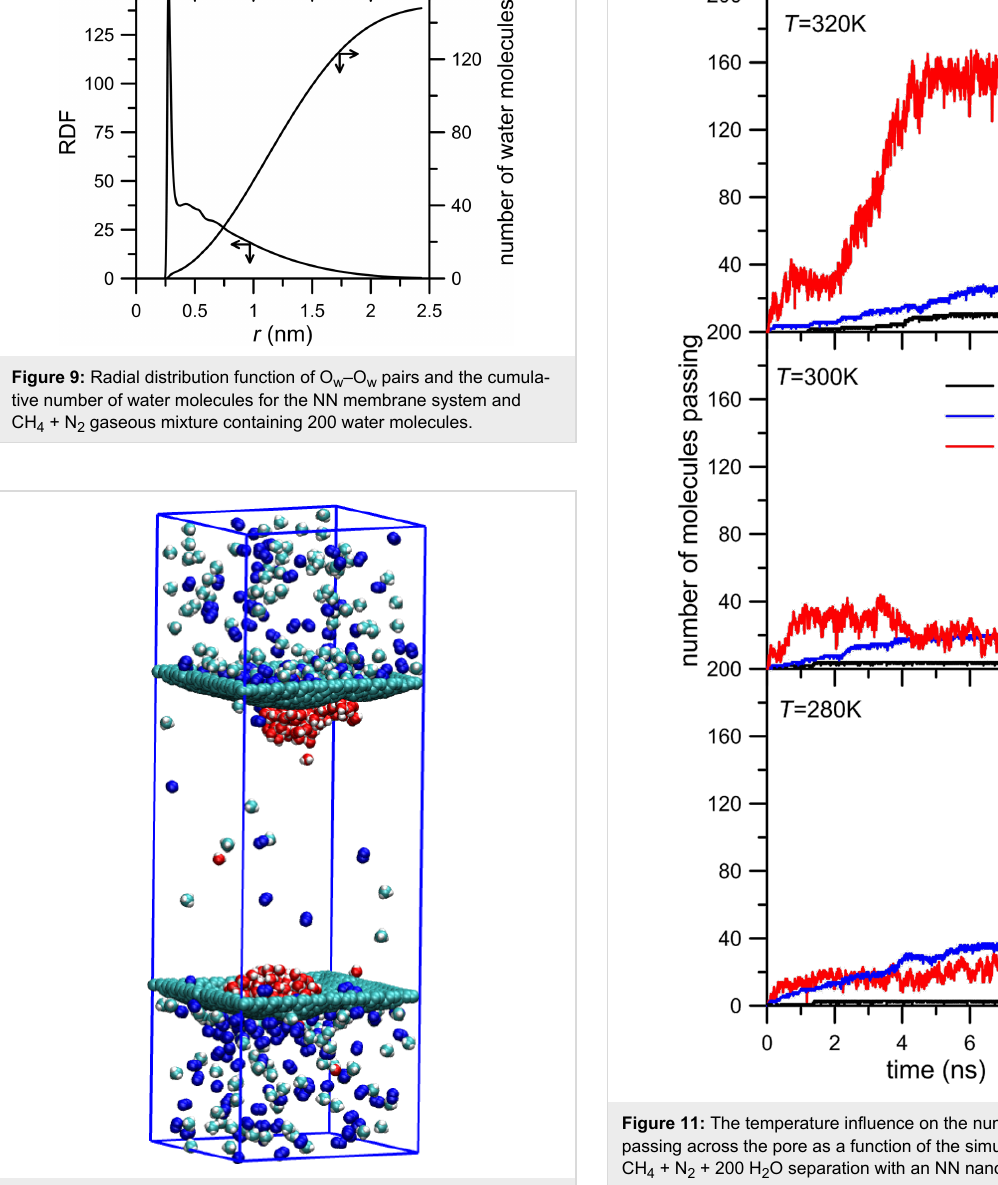
Figure 10: The extracted frame from the simulation trajectory of the separation of CH 4 + N 2 + 200 H 2 O with an NN nanopore at a time of 5 ns. Green, blue and red molecules are methane, nitrogen and water, respectively.